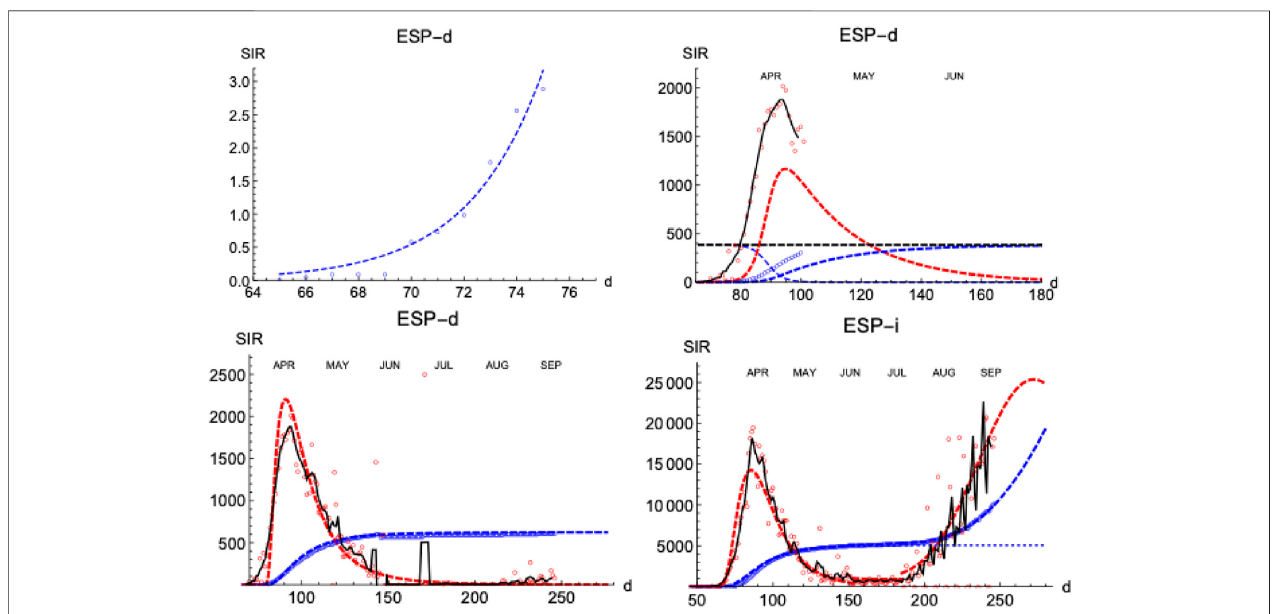
FIGURE 8 | SIR/Spain. Left upper panel: exponential fi t near the onset. Right upper panel: initial iteration for deaths (see text). Left lower panel: fi nal iterations for deaths. Right lower panel: fi nal iterations for infections. Blue: accumulated cases, R ( t ) (per million people). Red: daily cases, I ( t ) ( × 100 to increase visibility in the same scale as R ). Black is a 7 days moving average of data to help the eye.